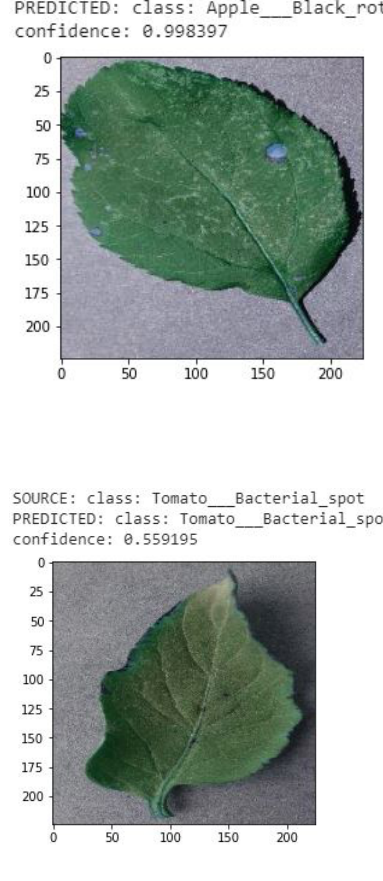
Figure 9. Example of correct classification from test image